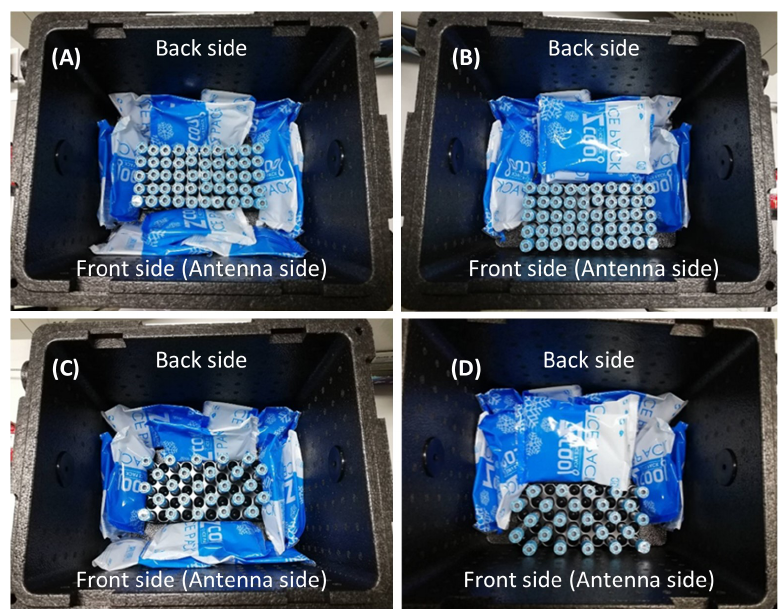
Figure 6. Experiment determining the number of specimen tubes. The tubes are empty. 50 tubes with ice bags surround ( A ), 50 tubes with no ice bags at antenna side ( B ), 25 tubes with with ice bags surround ( C ), and 25 tubes with no ice bags at antenna side ( D ).